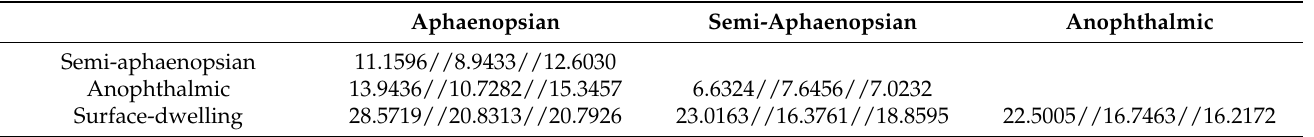
Table 1. Mahalanobis distances from four adaptive types of ground beetles based on the head, pronotum, and elytra, respectively.